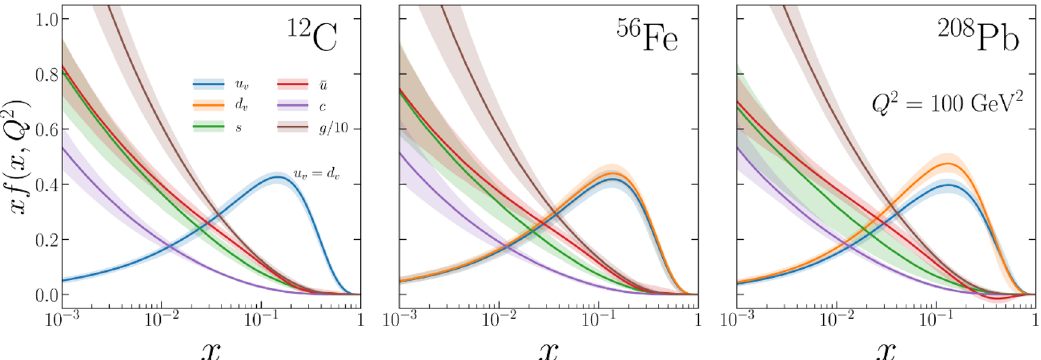
Figure 9 . The nNNPDF2.0 set of nuclear PDFs for 12 C, 56 Fe, and 208 Pb at the scale Q = 10 GeV. We display the gluon, the up and down valence quarks (which coincide for isoscalar nuclei), as well as the down, strange, and charm sea quark distributions. The bands indicate the 90% CL uncertainty